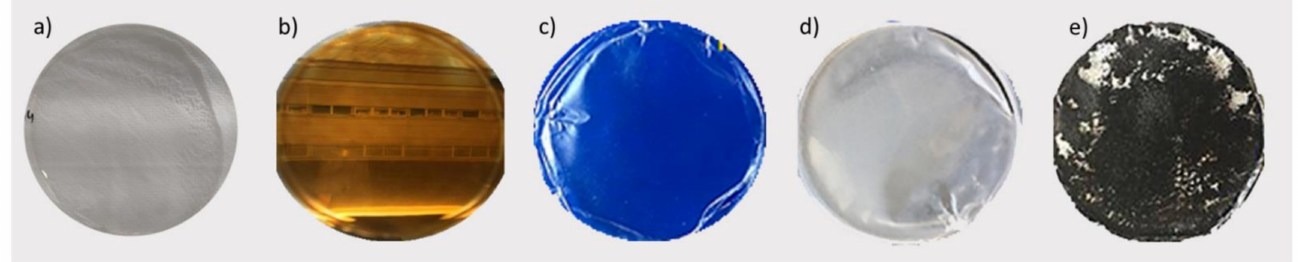
Figure 3. Images of the different PIMs: ( a ) M1; ( b ) M2 (0.5% Fe 3 O 4 ); ( c ) M4 (1% SiO 2 ); ( d ) M8 (1% TiO 2 ); ( e ) M11